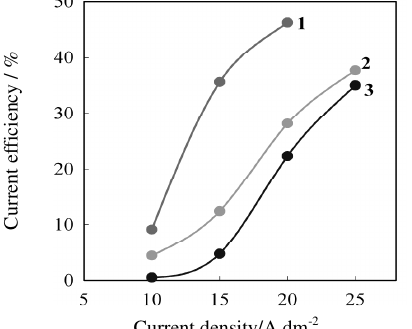
Figure 1. Dependences of current efficiency on current density at different bath temperatures: ( 1 ) 30 ° C, ( 2 ) 35 ° C, ( 3 ) 40 ° C basic bath composition; pH